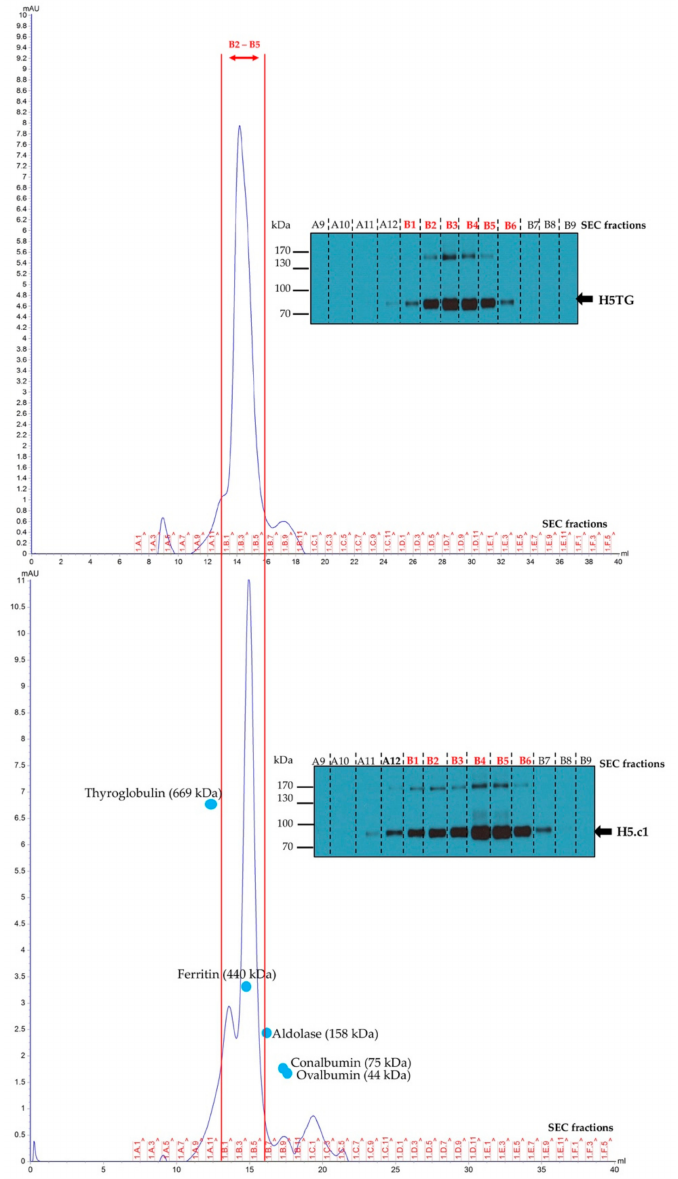
Figure 5. Structural characterization of the purified haemagglutinin (HA) proteins by size exclusion chromatography (SEC) and the A9–B9 SEC fractions analyzed by SDS–PAGE 10% under reducing conditions and Western blot using an anti–c–myc